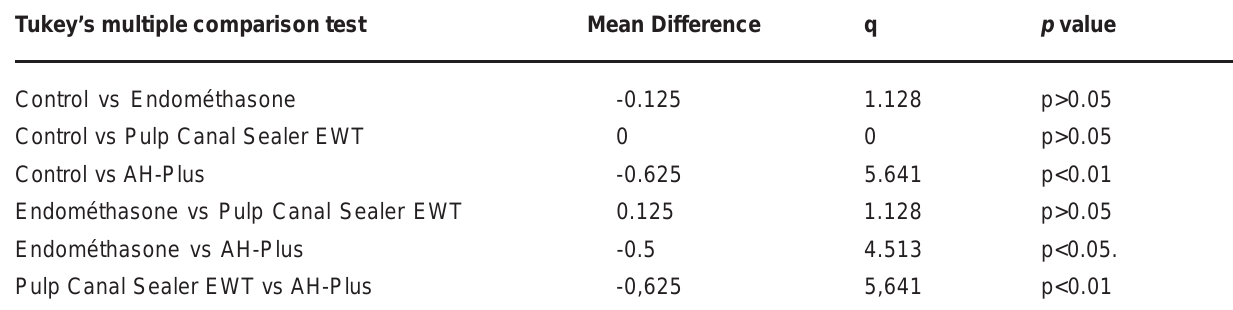
TABLE 6- Results of Tukey’s multiple comparison test for the scores attributed to the materials (Day Tukey’s multiple comparison test